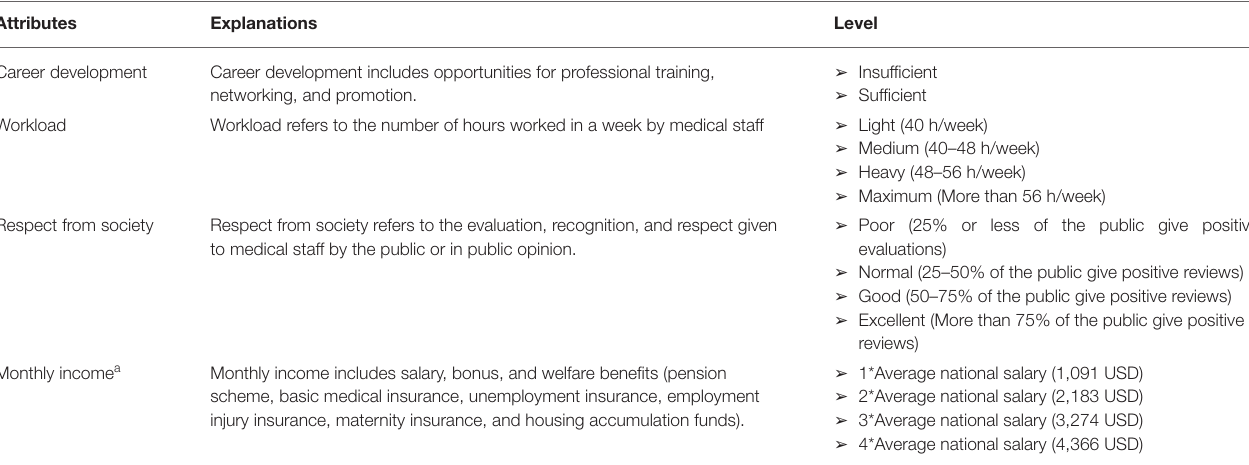
TABLE 1 | Detailed explanations of attributes and levels. Attributes Explanations Level Career